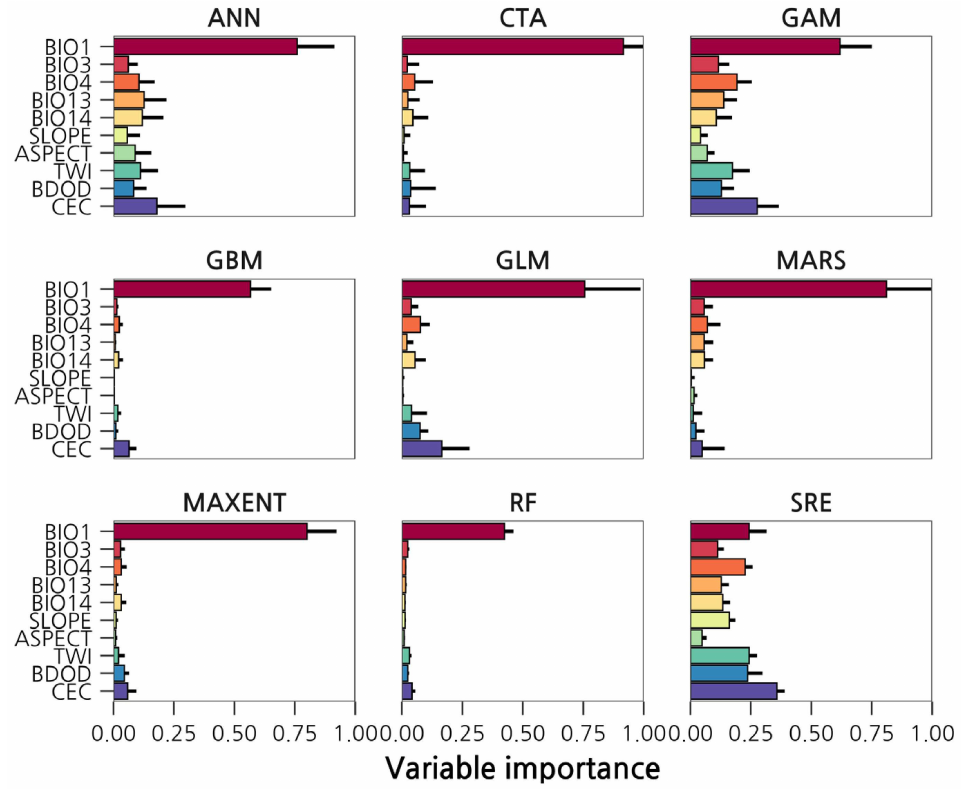
Figure 4. Importance values of the 10 environmental variables on the prediction of the occurrence of Angelica gigas by the single algorithm models. The bars and error bars represent the mean and standard deviation of the importance value for 100 models of each